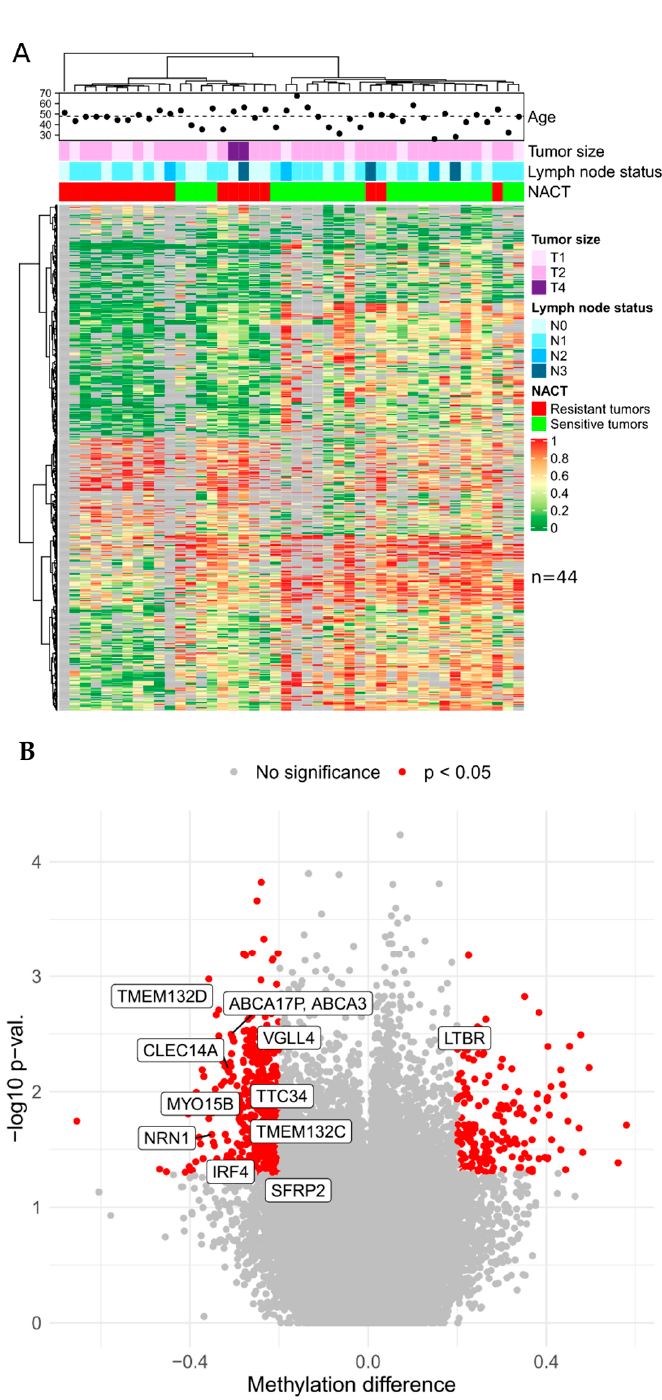
Figure 2. ( A ) Genome-wide bisulfite DNA sequencing (XmaI-RRBS) results from luminal B breast cancer samples obtained before neoadjuvant chemotherapy. The heat map shows the level of methylation: red—100%, yellow—50%, green—0%, gray—missing data in NACT-sensitive and -resistant luminal B breast cancer samples. Each row represents the methylation of a CpG dinucleotide in the samples by column. ( B ) Volcano plot indicating differentially methylated CpG-dinucleotides in luminal B tumors. X -axis represents methylation difference between resistant and sensitive tumor samples; Y -axis stands for − log10 scaled nominal p -value. Most informative CpG-pairs revealed by MSRE-qPCR in an independent cohort are marked with gene names they map